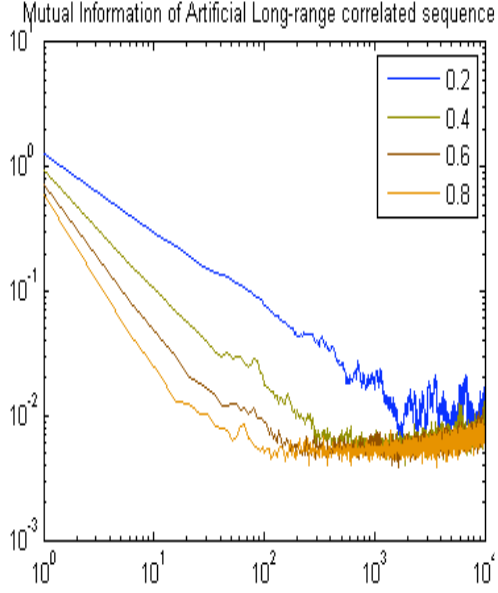
Fig. 3. Autocorrelation function of long-range correlated data (Makse et al., 1996). The correlations are weaker for higher val- ues of the exponent (0.2, 0.4, 0.6 and 0.8).